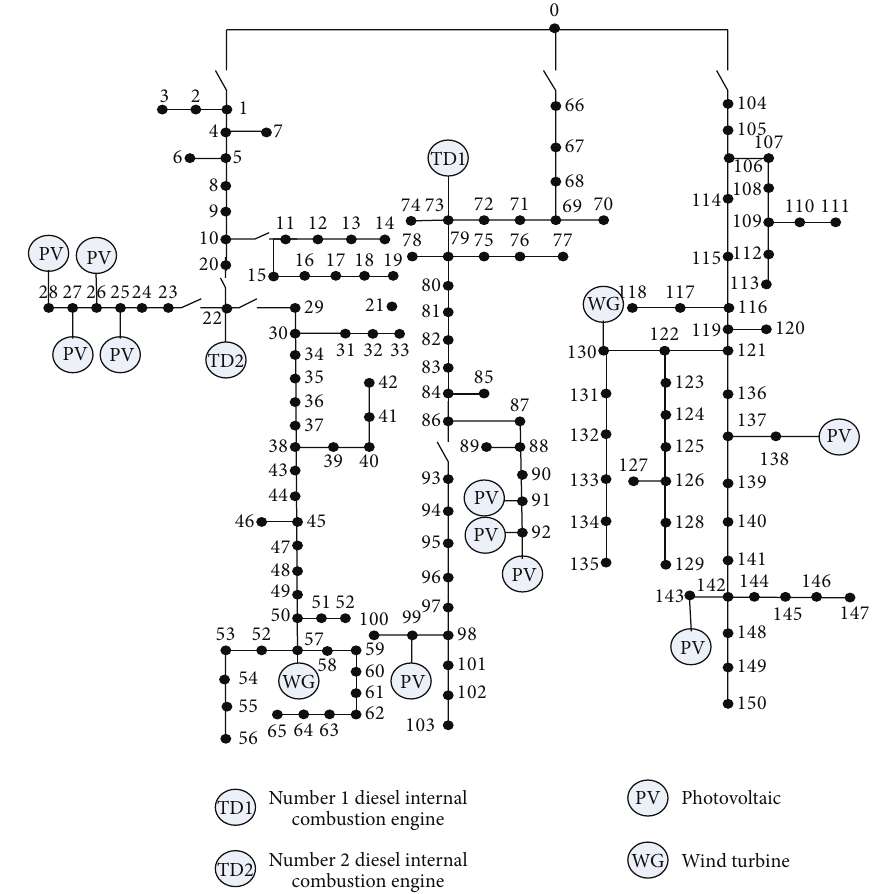
Figure 2: A real 150-node SMG system.